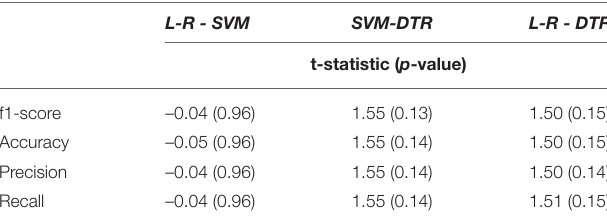
TABLE 3 | The two-tailed t -test between L-R, SVM and DTR and f1-score, accuracy, recall and